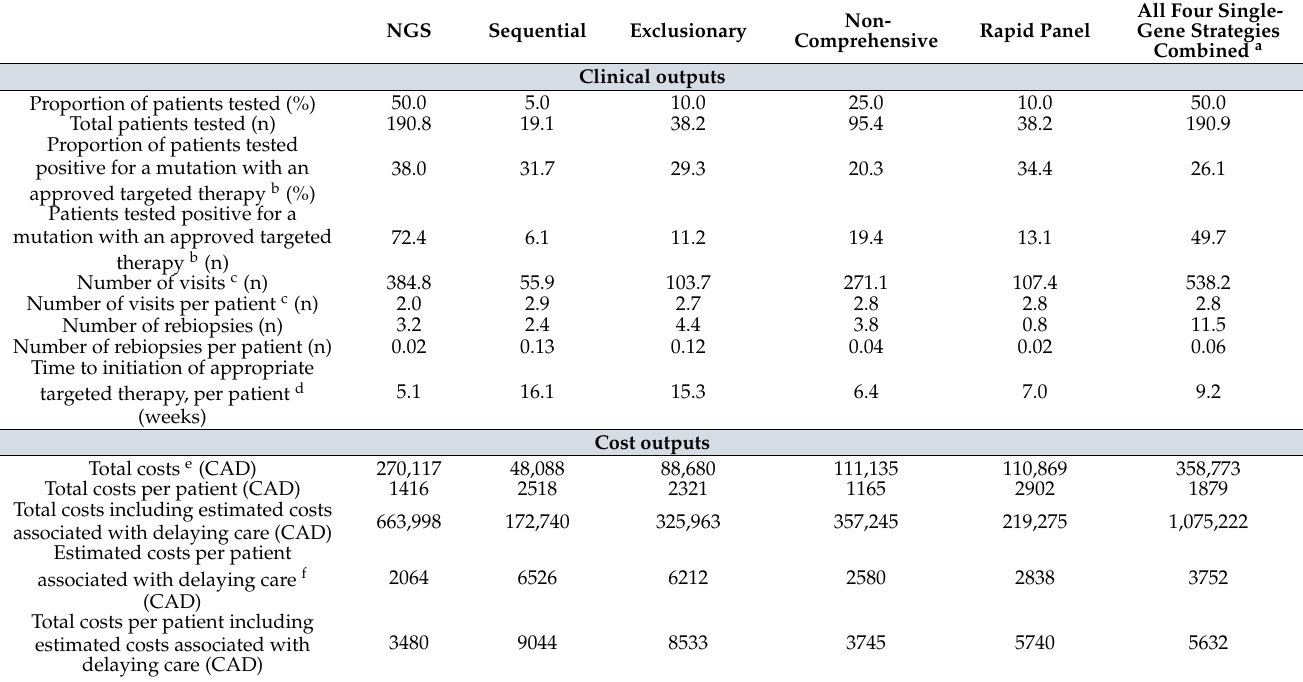
Table 2. Model output